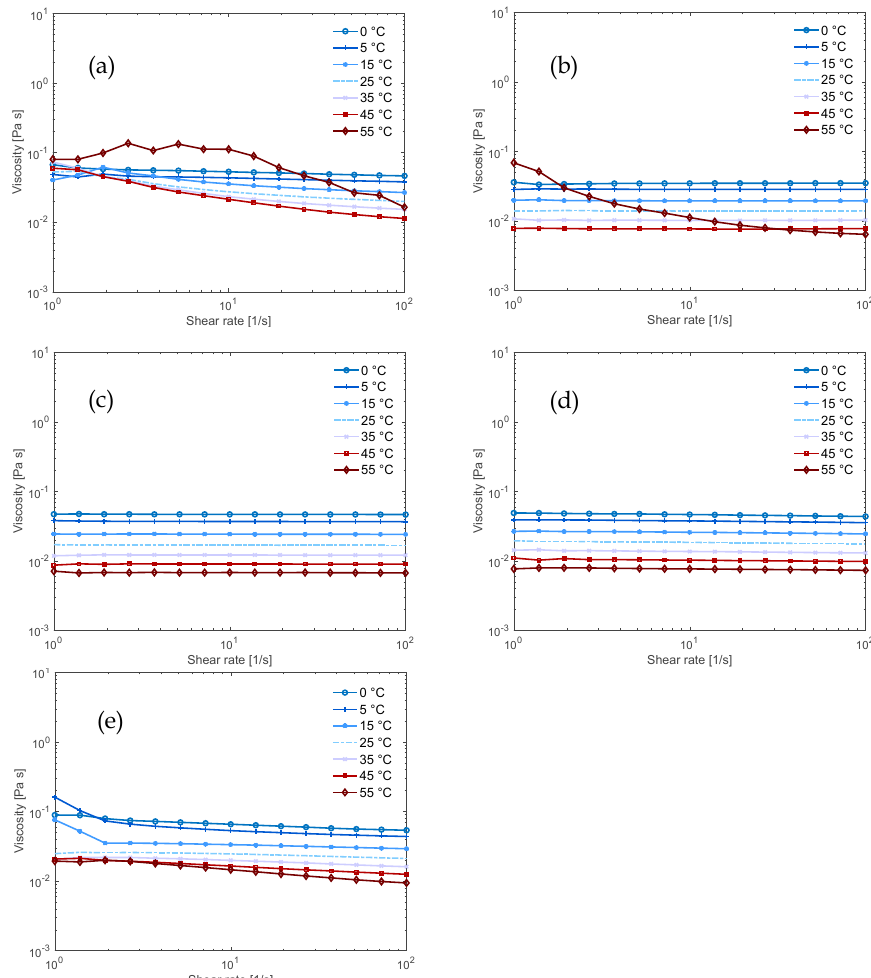
Figure 4. Flow sweeps of 0.34 mol% MCC in 3.8 mol% base and 4.4 mol% urea aqueous solution (11:1:266:13 molar ratio of base:AGU:H 2 O:urea) in ( a ) NaOH; ( b ) TMAH; ( c ) Triton B; ( d ) 50/50 NaOH/TMAH; ( e ) 50/50 NaOH/Triton B.